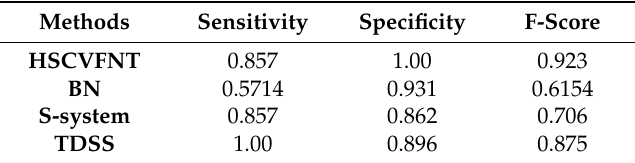
Table 1. Comparison of four methods for SOS network inference.